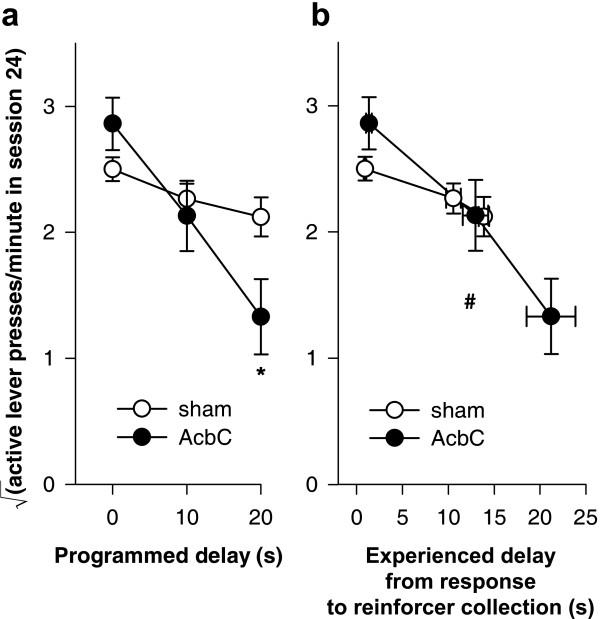
Performance as a function of delays to reinforcement in animals trained preoperatively Response-reinforcer delays systematically lowered the rate of free-operant instrumental responding, and this relationship was altered in AcbC-lesioned rats, even allowing for differences in response-collection delays experienced postoperatively. Lesions were made after initial training; postoperative experienced delays and response rates are plotted. (Compare Figure 7, in which rats had no preoperative experience of the task.) (a) The rate of responding on the active lever in session 24 (the 10th postoperative session; compare Figure 7) is plotted against the programmed response-reinforcer delay. AcbC-lesioned rats responded significantly less than shams in the 20 s delay condition (* p = .025). (b) Responding on the active lever in session 24 (the 10th postoperative session) plotted against the experienced response-to-reinforcer-collection delays for postoperative sessions up to and including session 24 (vertical error bars: SEM of the square-root-transformed number of responses in session 24; horizontal error bars: SEM of the experienced response-collection delay). The gradients of the two lines differed significantly (# p = .015; see text), indicating that the relationship between experienced delays and responding was altered in AcbC-lesioned rats, compared to sham-operated controls.